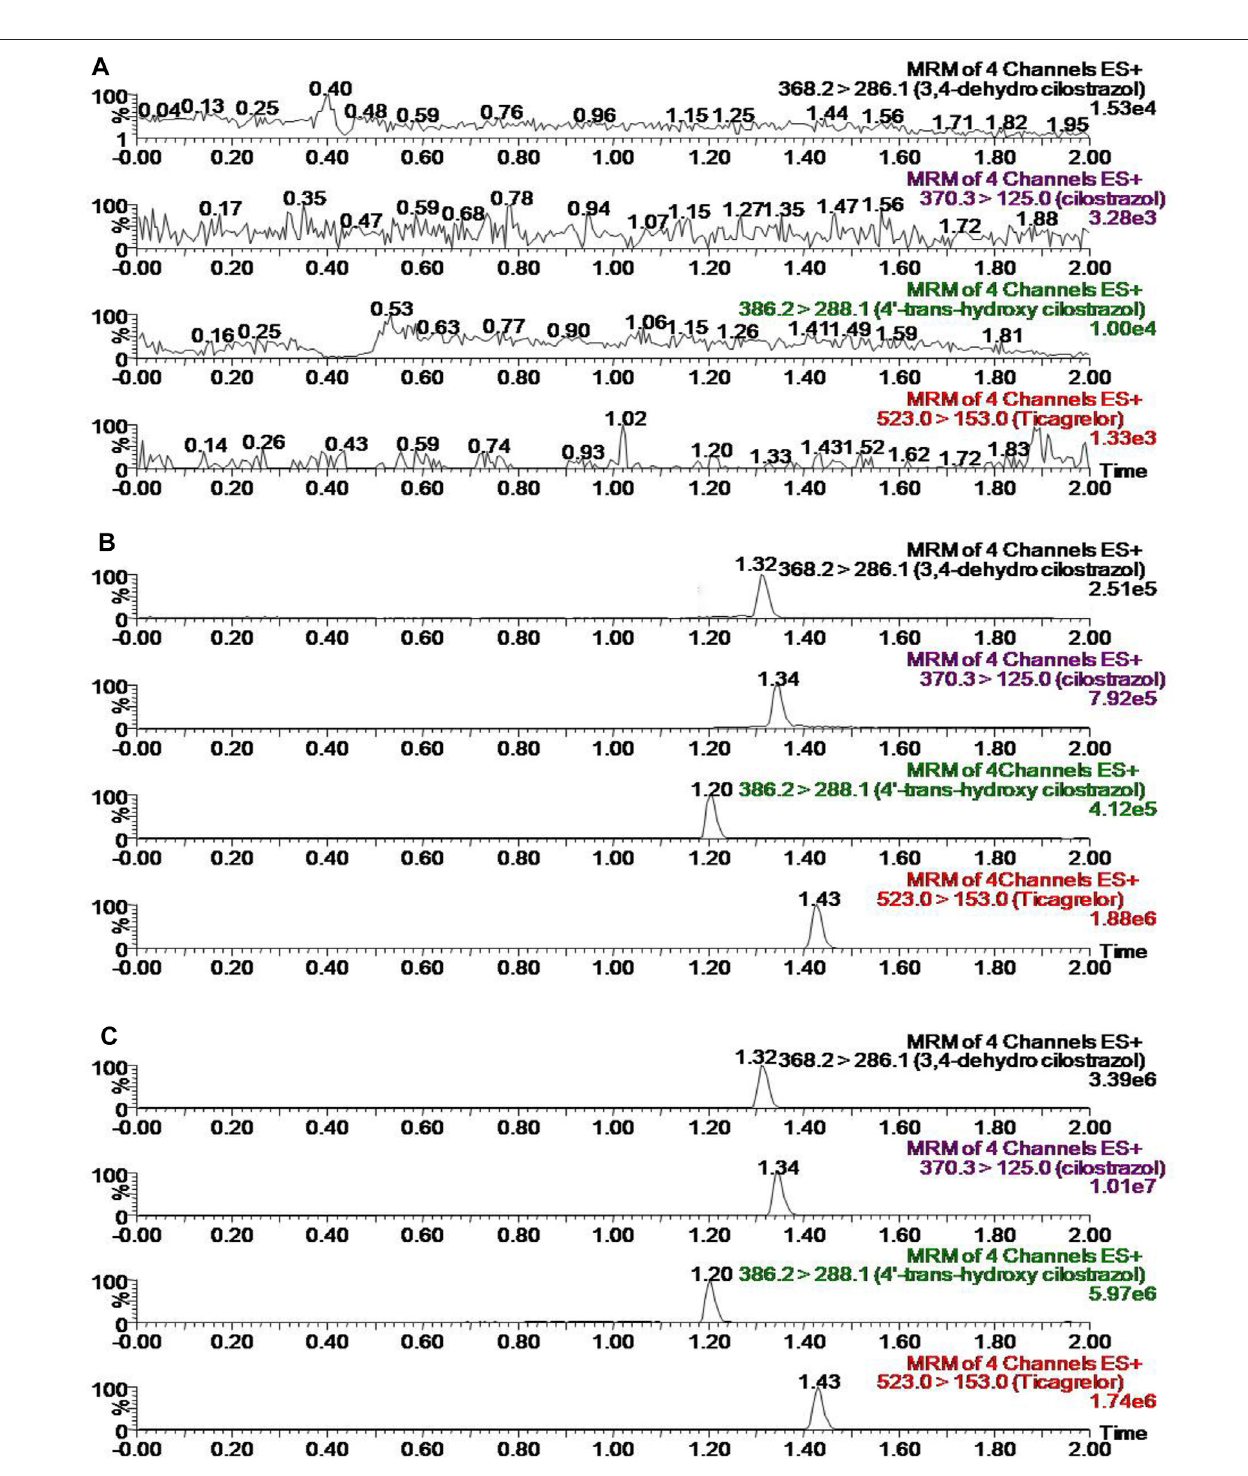
FIGURE2| Representativechromatograms ofcilostazol,its metabolitesandISinratplasma (A) blankplasma (B) blankplasmaspikedwithstandardsolutions (C) sample from a rat at 1.0 h after gavage with 10 mg/kg cilostazol and a subsequent standard plasma preparation.